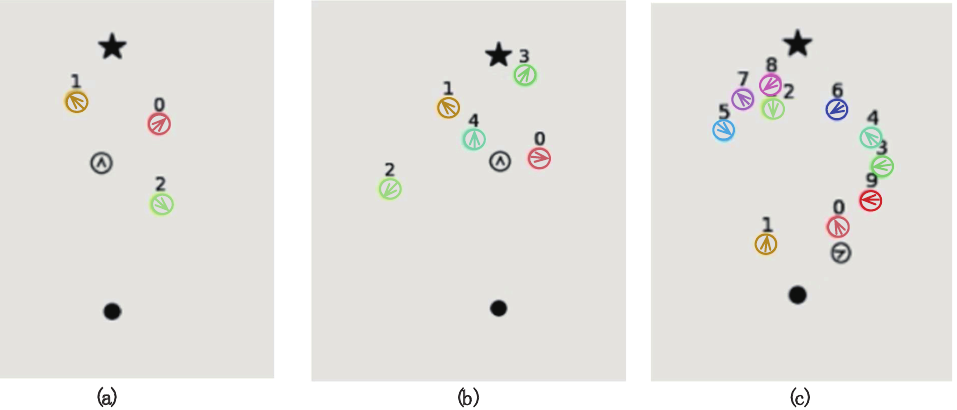
Figure 5. The black circle represents mobile robot. Colored circles represent human. The black star represents the target point. ( a ) shows robot navigation scene when the number of humans is 3, ( b ) shows robot navigation scene when the number of humans is 5, and ( c ) shows robot navigation scene when the number of humans is